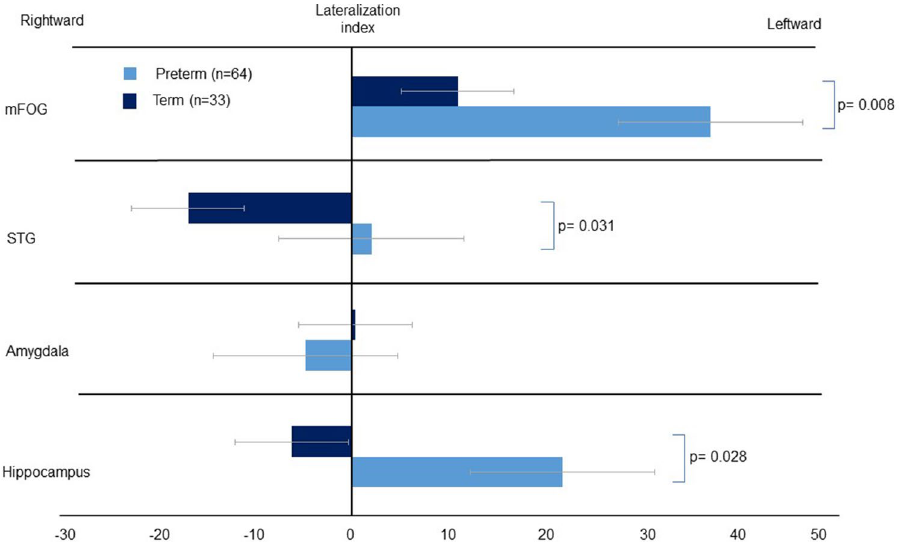
Figure 2. The comparison of the lateralization index of the betweenness centrality in the fronto-limbic network of both preterm and full-term infants. We controlled for sex, age at MRI scan, and bronchopulmonary dysplasia when performing the analyses. P values of ≤ 0.05 were considered to indicate statistical significance. All P values were corrected for the false-discovery rate. Abbreviations: mFOG, medial froto-orbital gyrus; STG, superior temporal